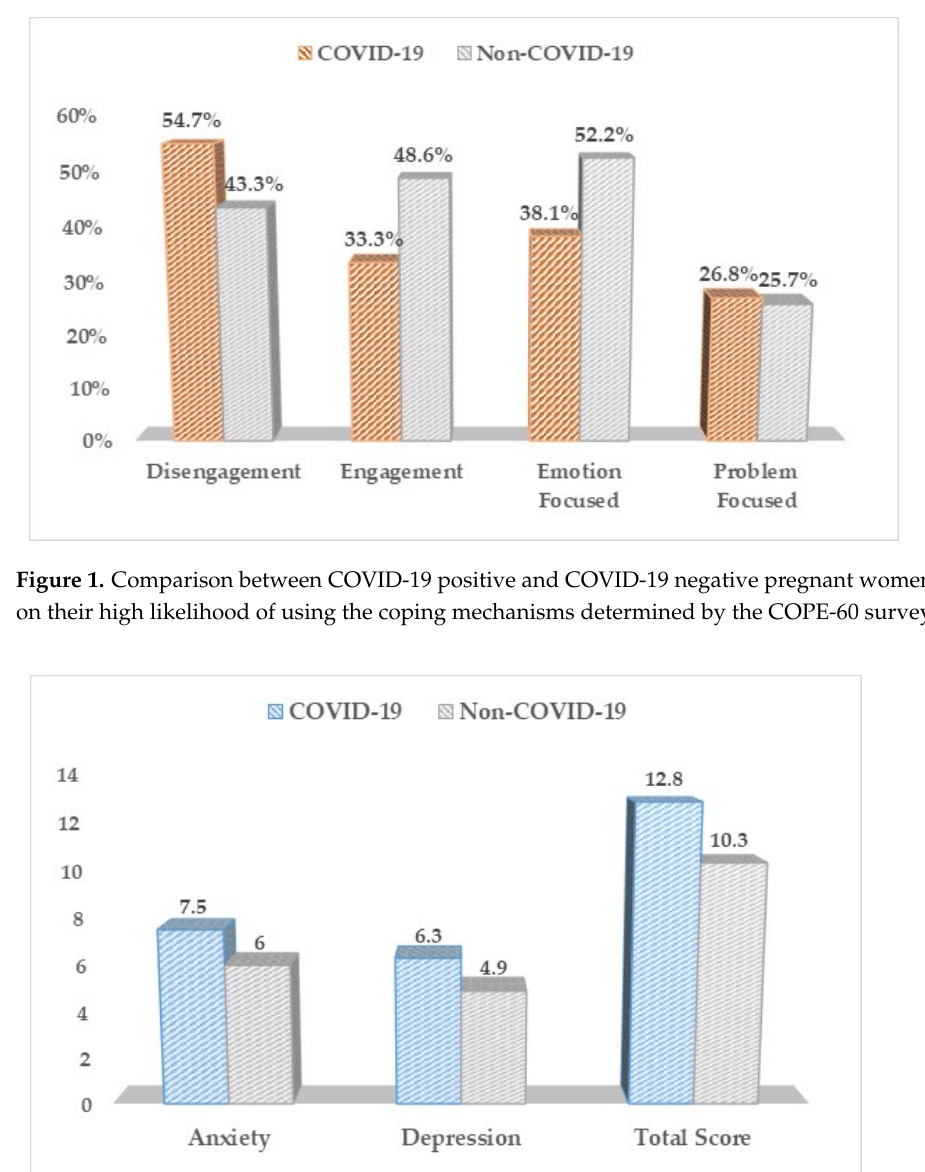
Figure 2. HADS questionnaire results between COVID-19 positive and negative pregnant women.